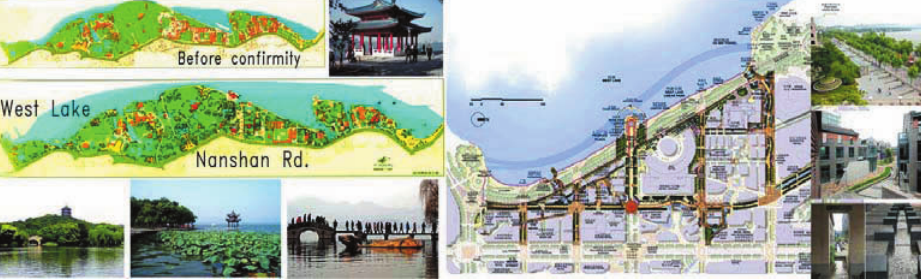
Fig.3 Landscape design Plan of South-line conformity project